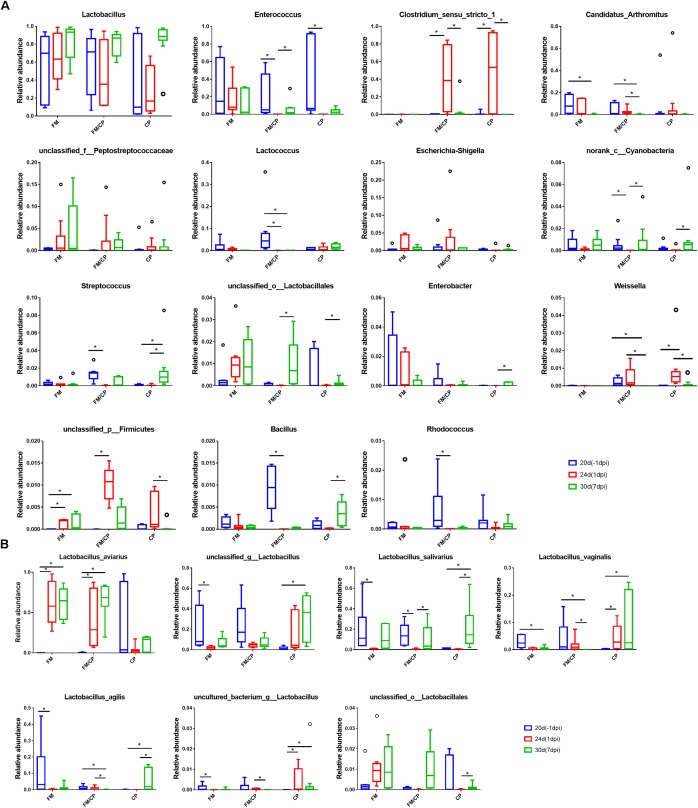
Comparison of bacterial composition using relative abundance. At the genus (A) and species (B) level. ∗p < 0.05, Kruskal–Wallis test.